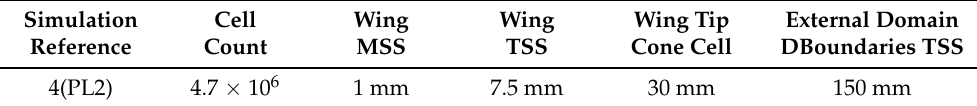
Table 9. Final Mesh with 4c inlet and 6c outlet (4c–6c Box).